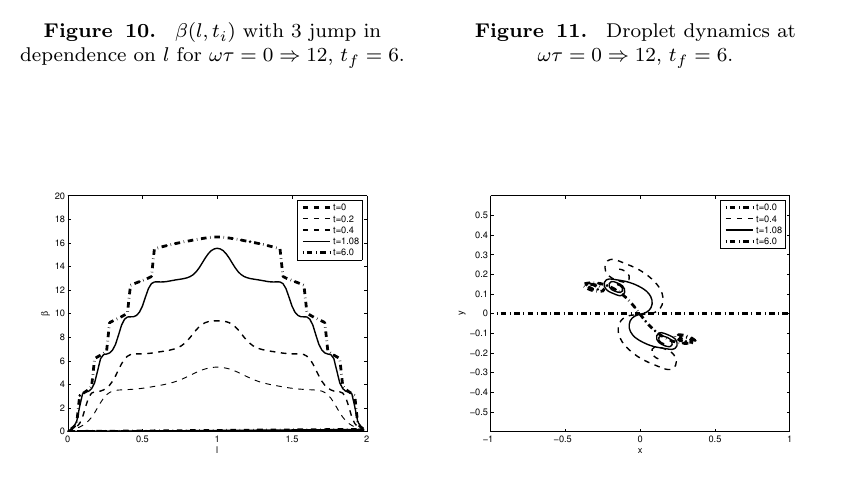
Figure 13. Droplet dynamics at ωτ = 0 ⇒ 24, t f =